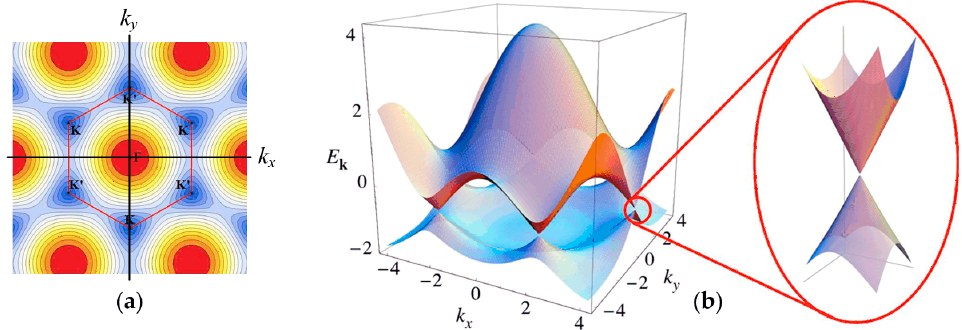
Figure 3. ( a ) Contour plot of the energy in the first Brillouin zone of graphene [42] and ( b ) elec- tronic energy dispersion in the honeycomb lattice. Left: energy spectrum for finite values of t and t’ with t= 2.7 eV and t’ = − 0.2t. Right: zoom-in of the energy bands close to one of the Dirac points (reprinted permission from [23]).